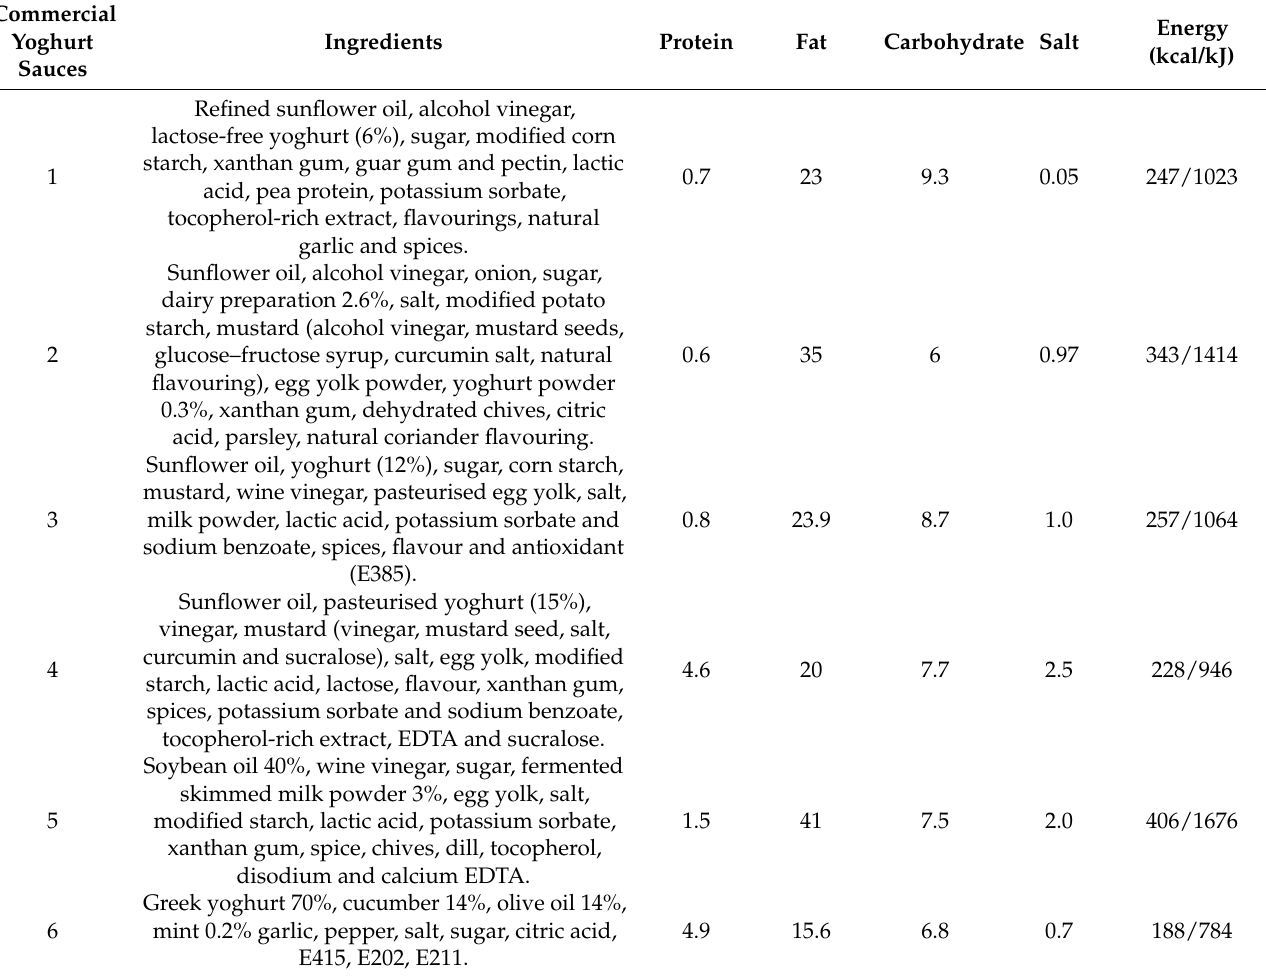
Table 3. Ingredients and nutritional declarations for six commercial yoghurt sauces (g/100